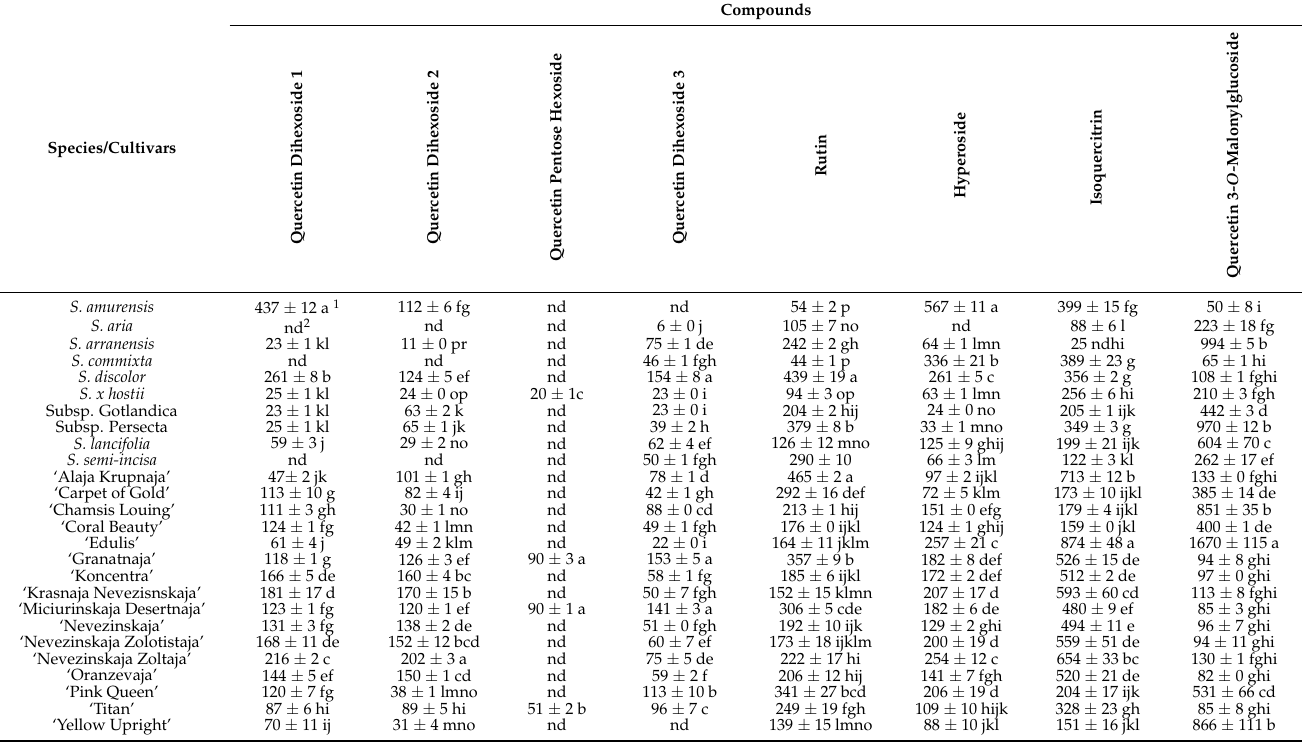
Table 2. Concentrations of quercetin derivatives ( µ g/g DW) in Sorbus inflorescences.